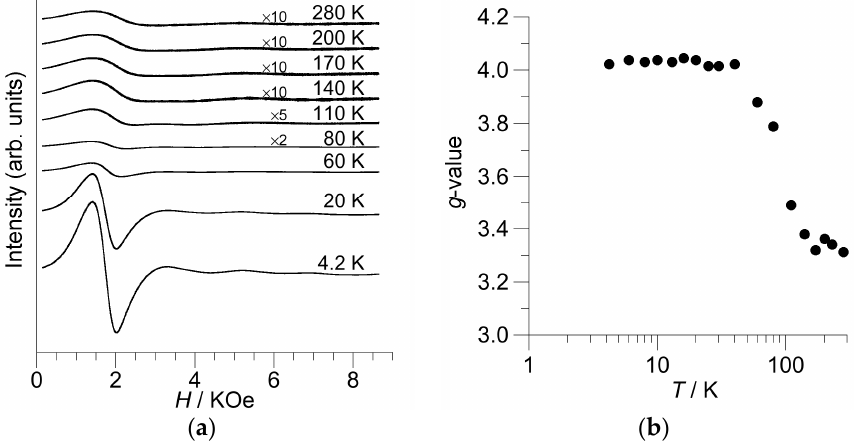
Figure 5. ( a ) Temperature dependence of electron paramagnetic resonance spectra for 1 ; ( b ) Temperature dependence of g -values for the absorption from the high-spin (HS) [Fe(qsal) 2 ]